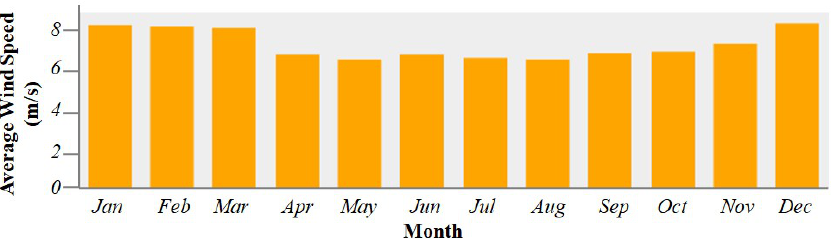
Figure 4. Monthly average wind speed variation of the location.